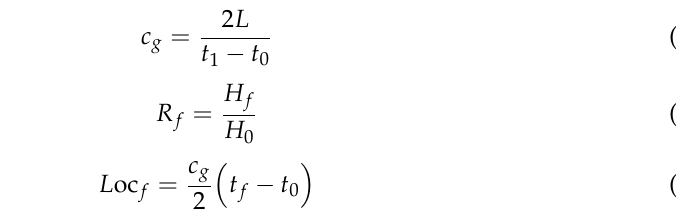
Figure 6. Time history and envelope of UGWs with central frequency of 60 kHz propagating in threaded rod.